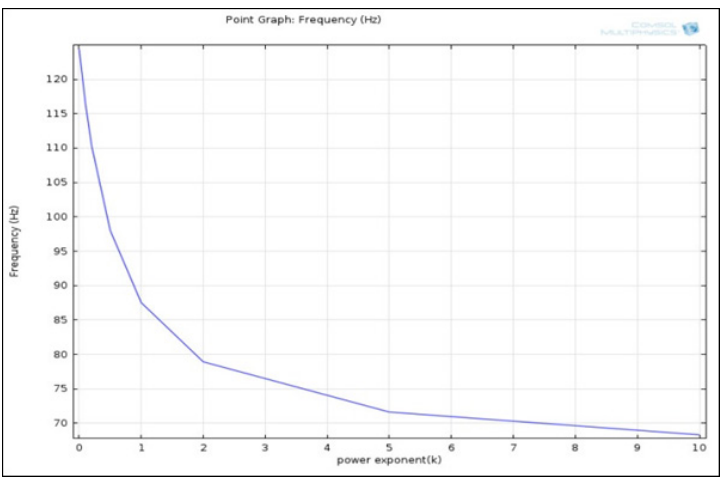
Figure 5: Variation of first Eigen frequency with power exponent Table 3: First three non-dimensional frequency (λ) for different mass density and young modulus variation L/h